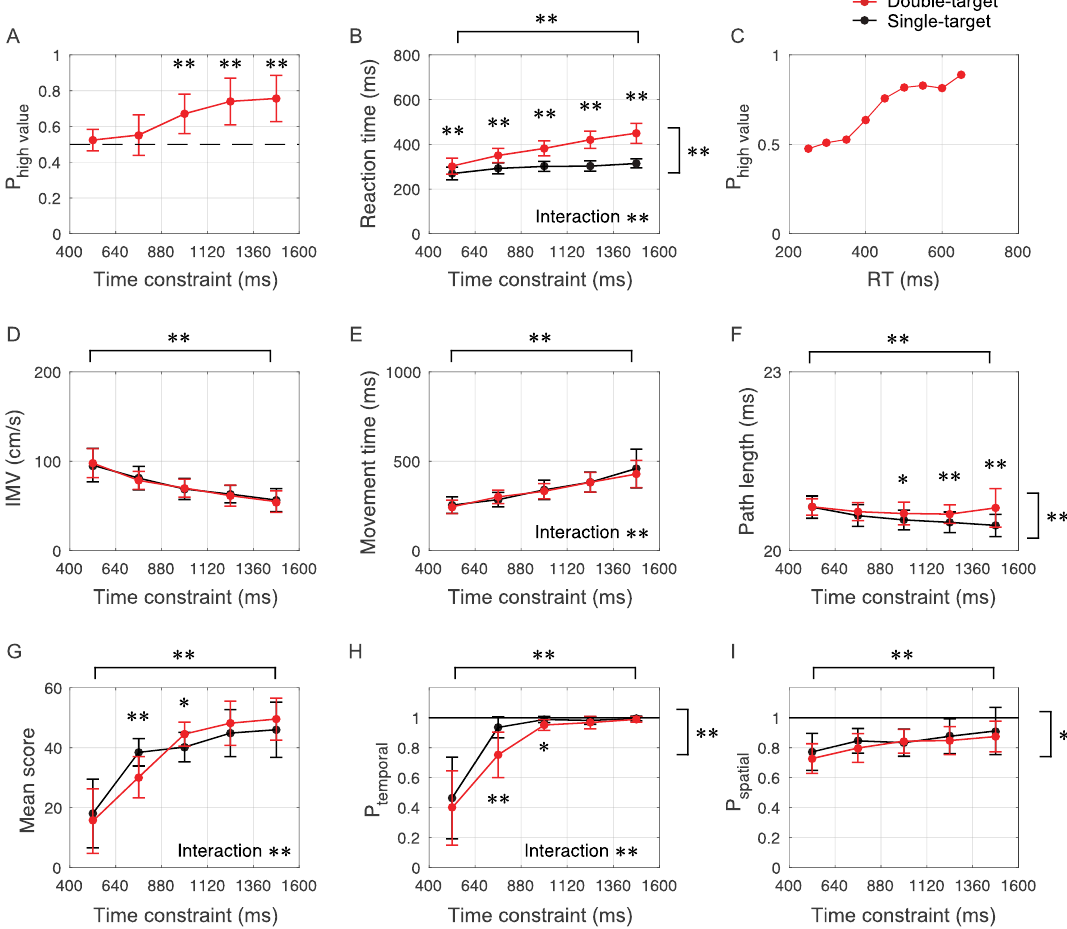
Figure 7. Comparison of execution strategy and performance according to time constraint between the double- target condition and the single-target condition. ( A , B , C ) The top row showed the probability of reaching a target with a higher score according to the time constraint (P high-value ), the reaction time according to the time constraint (RT), and the P high-value according to the reaction time. These panels show that the longer the time constraint, the larger the difference between the RT in the double-target and single-target conditions, and that longer RT in the double-target condition increased the probability of reaching a higher-value target. ( D , E , F ) The middle row showed the initial movement velocity (IMV), the movement time (MT), and the path length of the trajectory at a 20-cm Euclidian distance from the start position (PL) according to the time constraint. These panels indicate that the differences between the double- and single-target conditions did not significantly affect the time or speed of the movement. In addition, the trajectories were longer in the double-target condition than in the single-target condition when the time constraint was long. ( G , H , I ) The bottom panel showed the mean score, the temporal accuracy (P temporal ), and the spatial accuracy (P spatial ) according to the time constraint. The mean scores were higher in the double-target condition than in the single-target condition under a moderately tight time constraint, suggesting that the participants were not able to switch appropriately between simple and choice reactions. This was also supported by the fact that the P temporal was lower in the double-target condition than in the single-target condition under moderately tight time constraints. *: P < 0.05, **: P < was presented. Participants were instructed to maximize the mean score in each set. The mean score within a set was presented after each set was completed. The basic sequence of the task was the same as that for the main condition. The participants performed 324 trials (54 trials × 6 sets) of the task. Each set contained 36 trials in the double- target trials (3 angles × 12 trials) and 18 trials (3 angles × 6 trials) in the single-target trials. The directions of the targets were assigned evenly. Between sets, participants receive sufficient rest to avoid fatigue. Data analysis. The last five sets (double-target trials [180 trials], single-target trials [90 trials]) were included in the analysis to exclude data from the initial adaptation process to the task. The cursor position (horizontal position: Xc(t), vertical position: Yc(t)) at each time (t) was smoothed using a second-order low-pass Butter- worth filter with a cutoff frequency of 14 Hz.